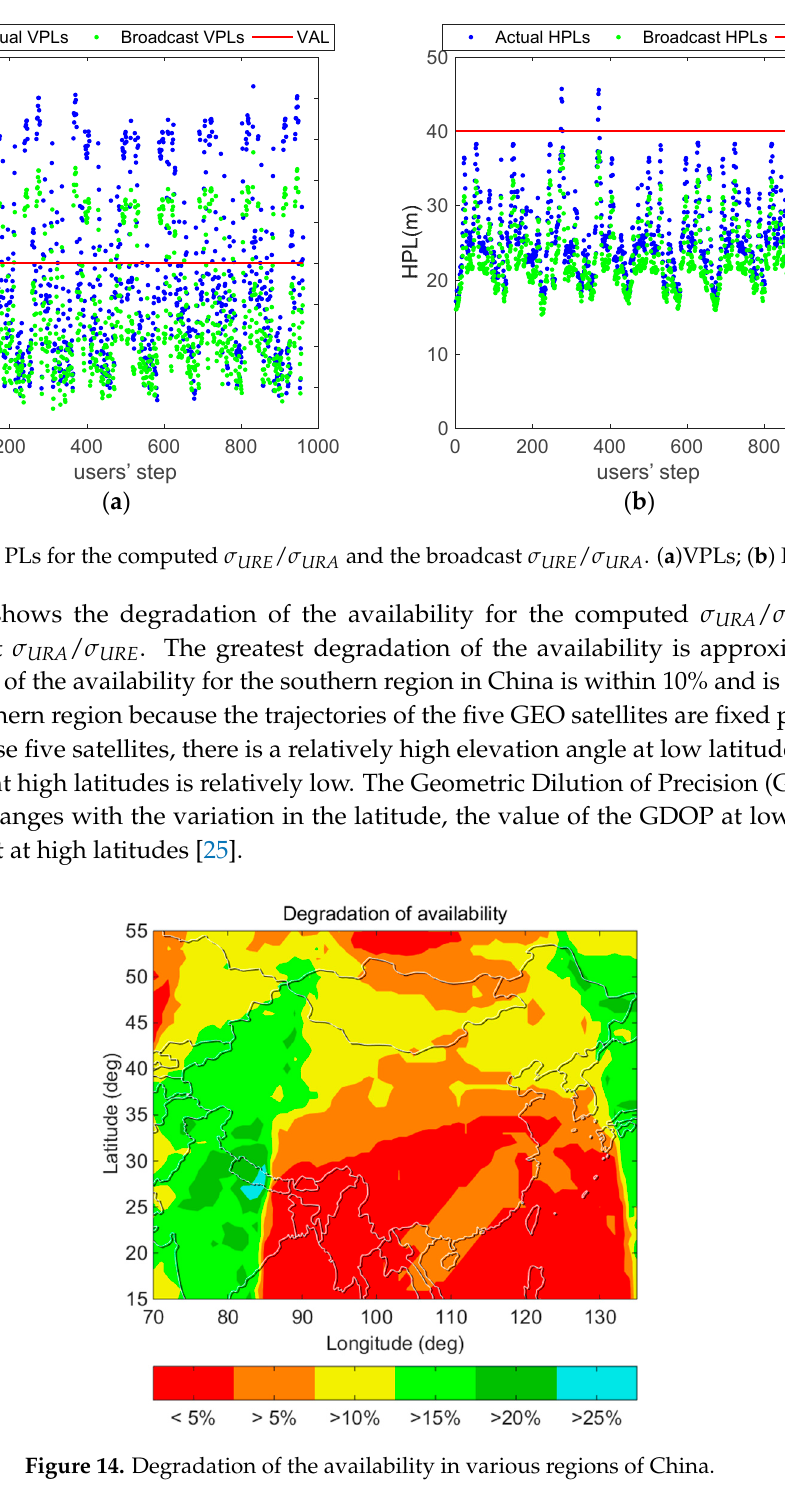
Figure 14. Degradation of the availability in various regions of China.